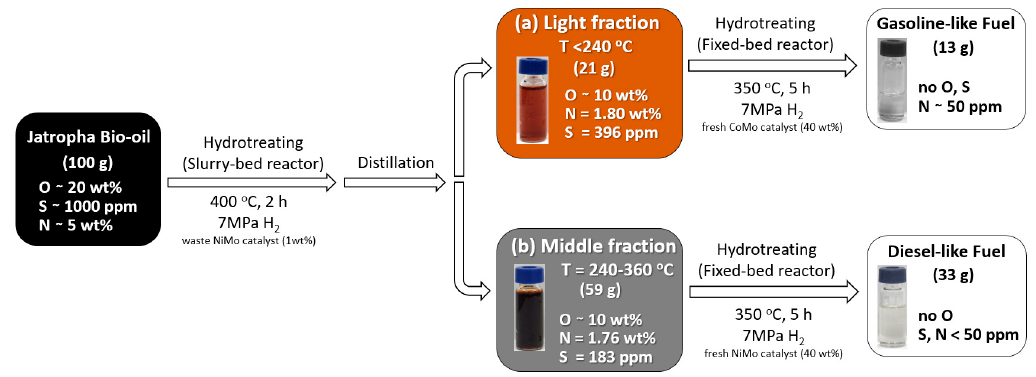
Figure 3. Stepwise hydrotreating of Jatropha bio-oil over sulfide catalysts to produce gasoline-like and diesel-like fuels ( a ) light fraction was obtained at the distillation temperature equal to or smaller than 240 ◦ C under 75 mmHg; ( b ) middle fraction was obtained at the distillation temperature between 240 and 360 ◦ C.